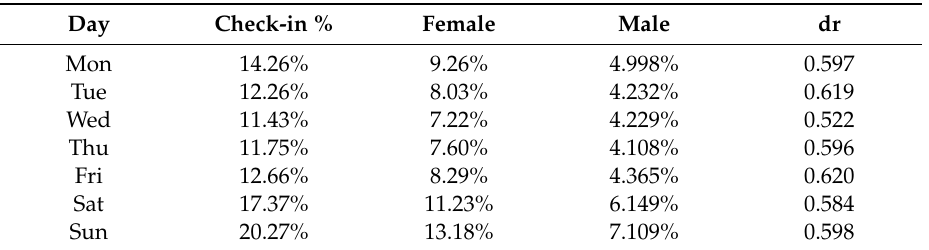
Table 7. Gender di ff erences on di ff erent days of the